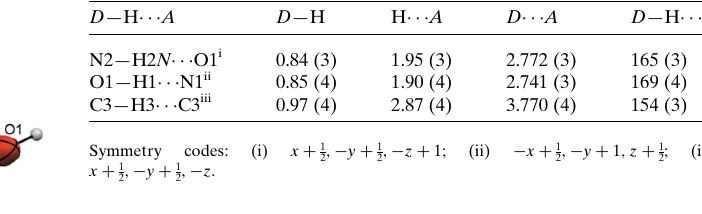
Table 2 Hydrogen-bond geometry (A˚ , (cid:4) ) for